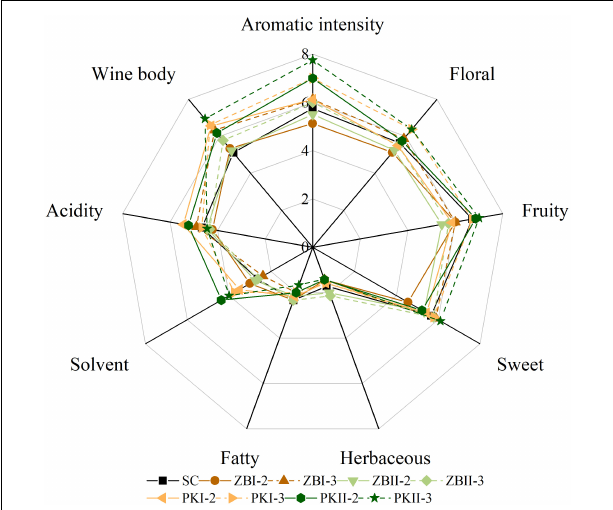
FIGURE 4 | Sensory evaluation of final Cabernet Sauvignon wines. SC, black solid line; ZBI-2, brown solid line; ZBI-3, brown dotted line; ZBII-2, olive green solid line; ZBII-3, olive green dotted line; PKI-2, orange solid line; PKI-3, orange dotted line; PKII-2, deep green solid line; PKII-3, deep green dotted